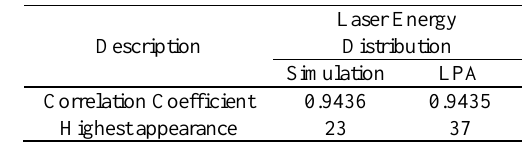
Table 6. Effect of Laser Energy Distribution on Simulation